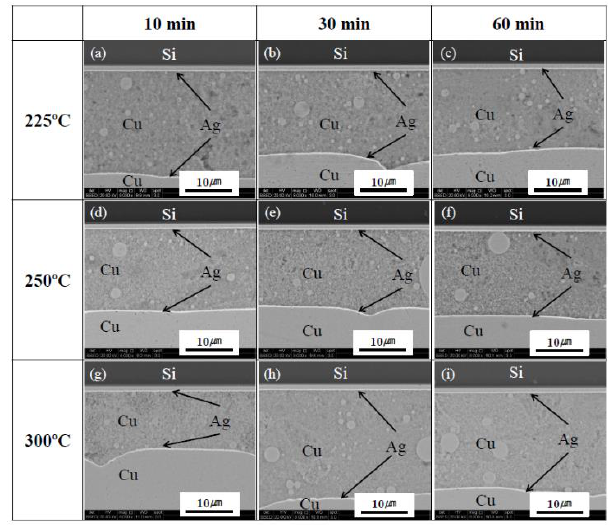
Figure 11. Cross-sectional SEM images of the Si chip/sintered Cu layer/DBC joints at different sintering temperatures and durations (10 MPa); ( a – c ) 225, ( d – f ) 250, and ( g – i ) 300 °C.